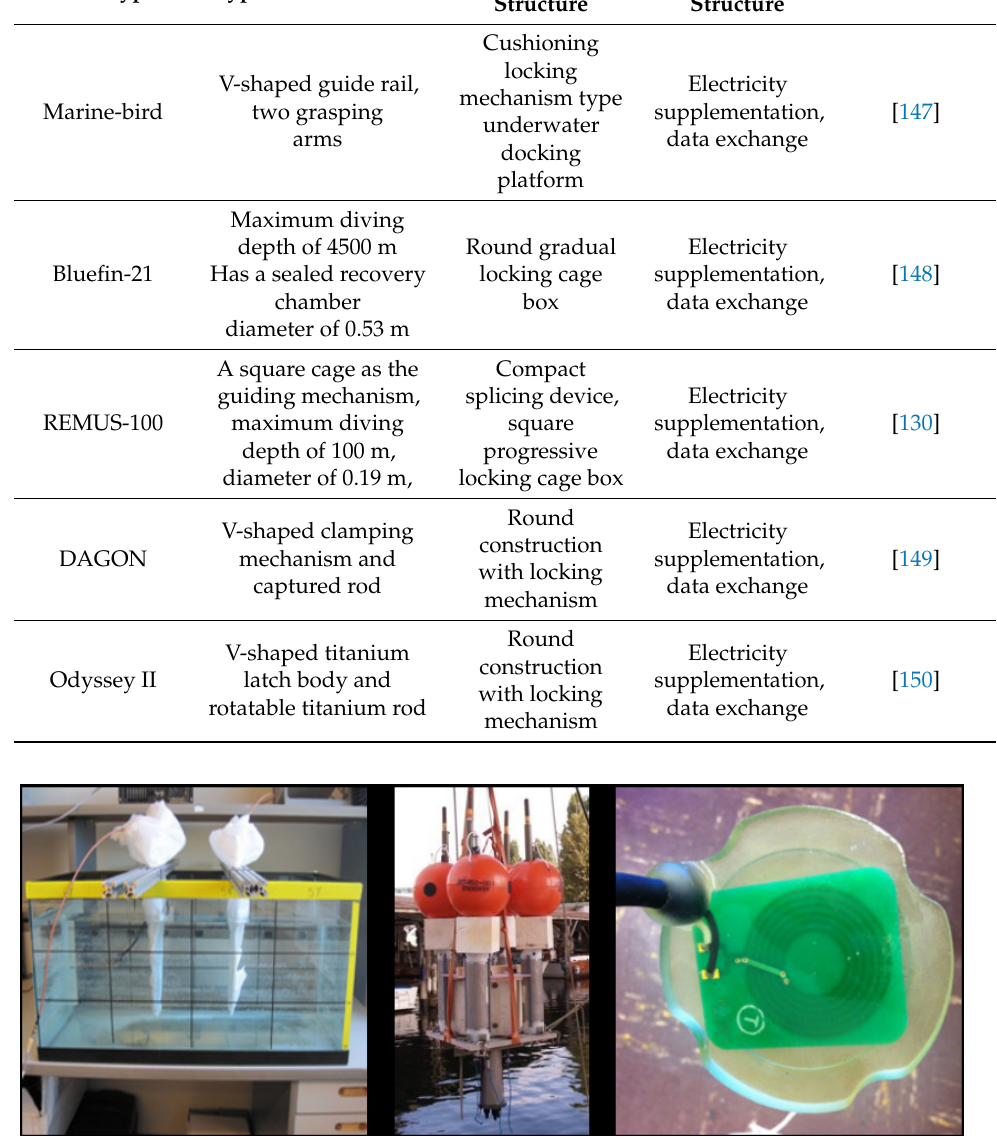
Figure 29. Deep-sea power and communication experiment